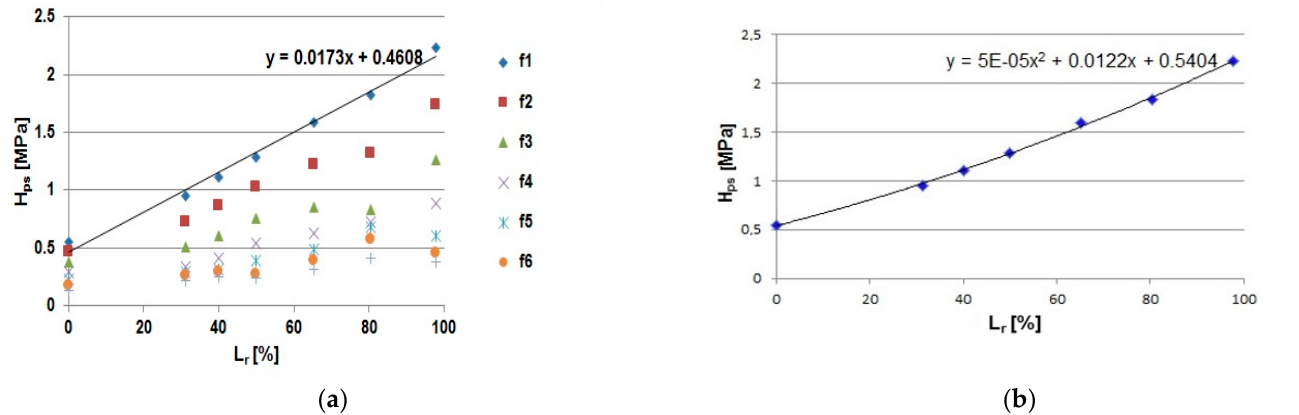
Figure 11. The impact of the relative load of the L r engine on values of the amplitudes of first seven harmonics of the in-cylinder pressure spectrum H ps ( a ) and amplitudes values of first harmonic of the in-cylinder pressure in the frequency band 0–100 Hz with approximation of the measuring points ( b ): f o —rotational frequency.